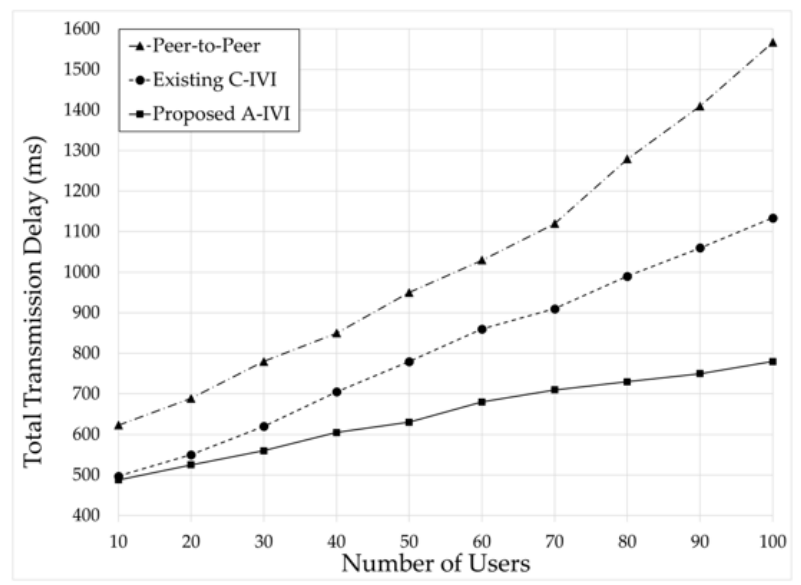
Figure 24. Total transmission delay for different number of users.